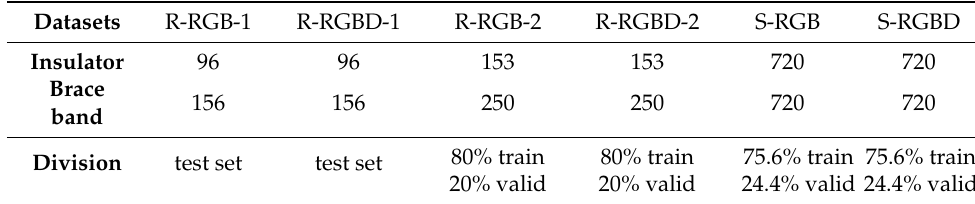
Table 1. Datasets of the experiment.